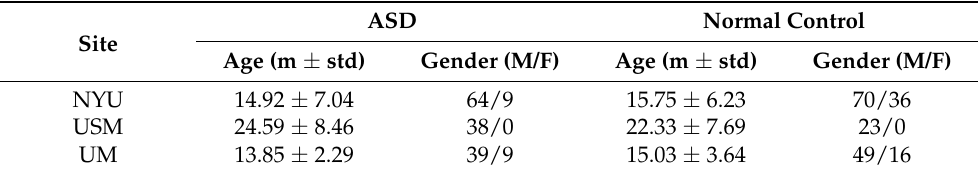
Table 2. Demographic information of the studied subjects from three imaging sites in the ABIDE database. The age values are denoted as the mean ± standard deviation. M/F: